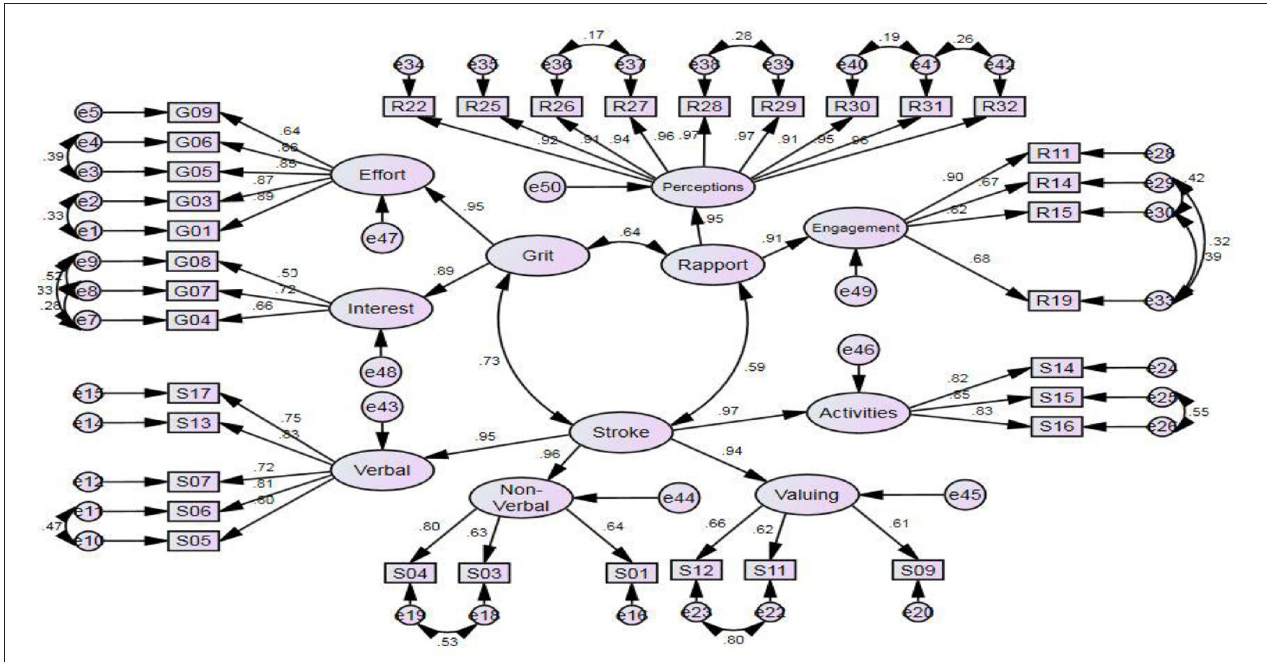
FIGURE 1 | The final modified CFA model with standardized estimates.